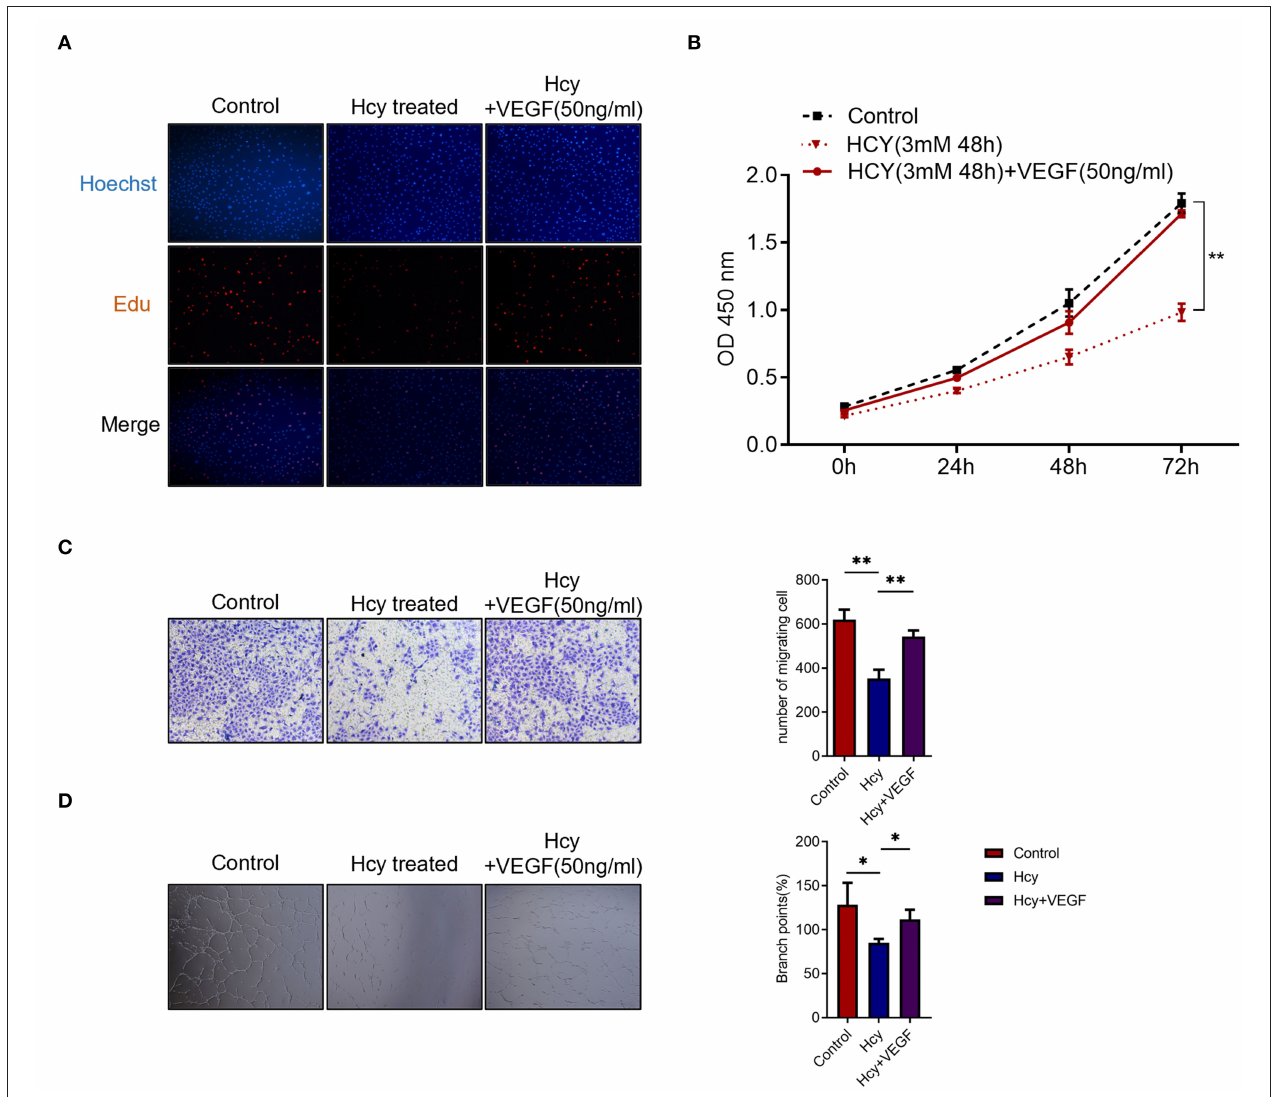
FIGURE 2 | Homocysteine (Hcy) inhibits the HBMECs proliferation, migration, and tube formation, which is reversed by VEGF. (A,B) Edu assay and CCK-8 assay of HBMECs treated with Hcy and VEGF165. (C,D) Transwell migration assay and tube formation assay of HBMECs treated with Hcy and VEGF165. * p < 0.05, ** p <